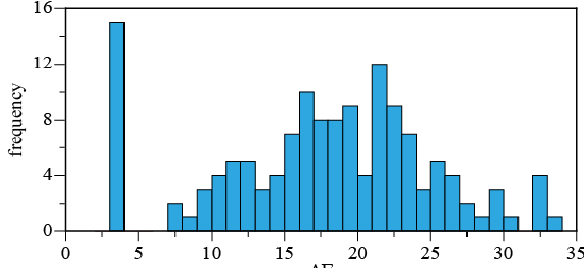
Figure 1. Camera color Δ E analysis result.